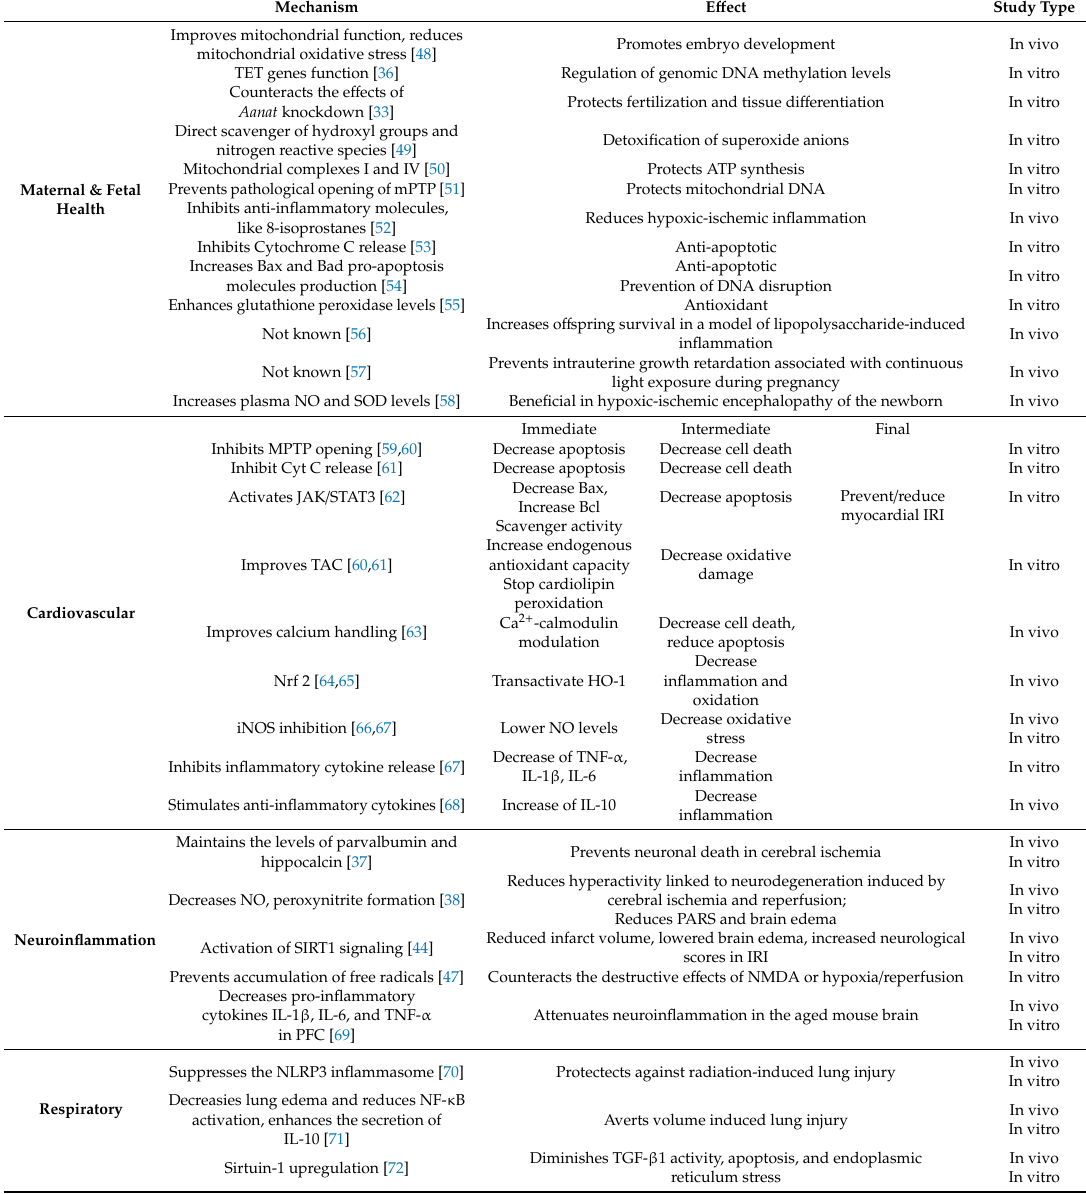
Table 1. Overview of the mechanisms of action and the protective e ff ects of